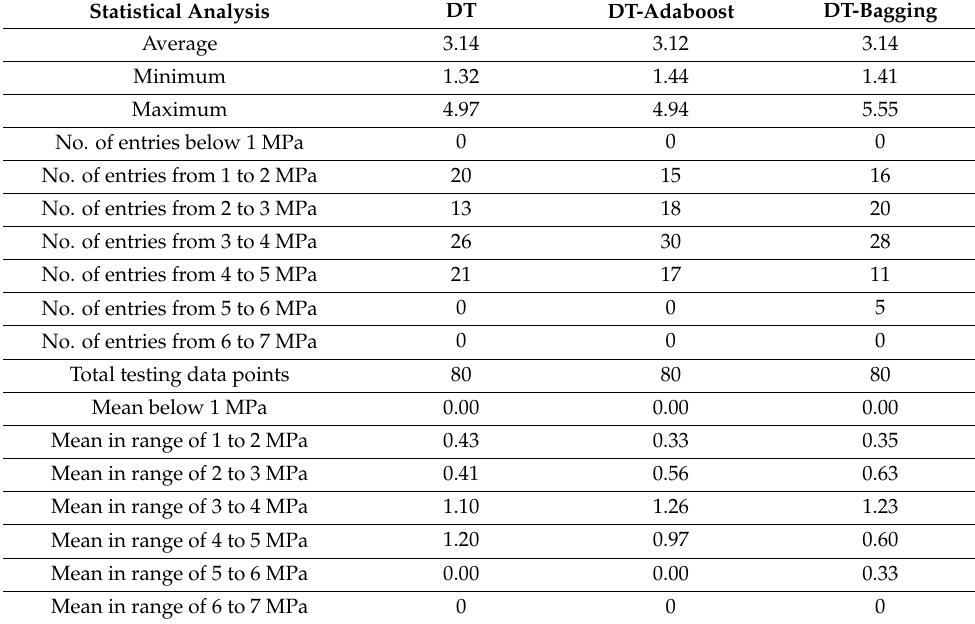
Table 10. Statistical analysis of tensile strength decision tree